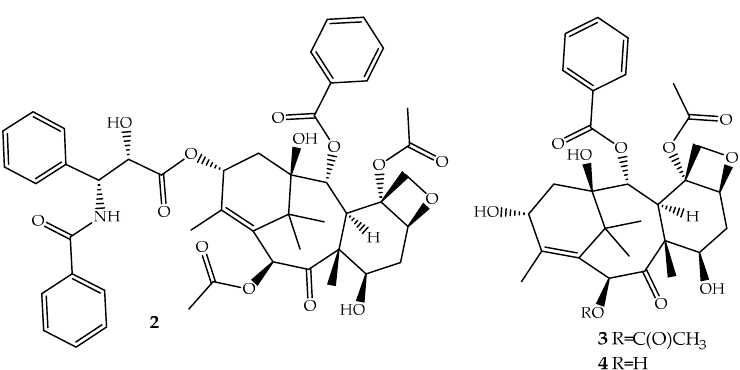
Figure 2. Chemical structure of paclitaxel ( 2 ), a natural microtubule inhibitor, and of its precursors baccatin III ( 3 ) and 10-deacetylbaccatin III ( 4 ).